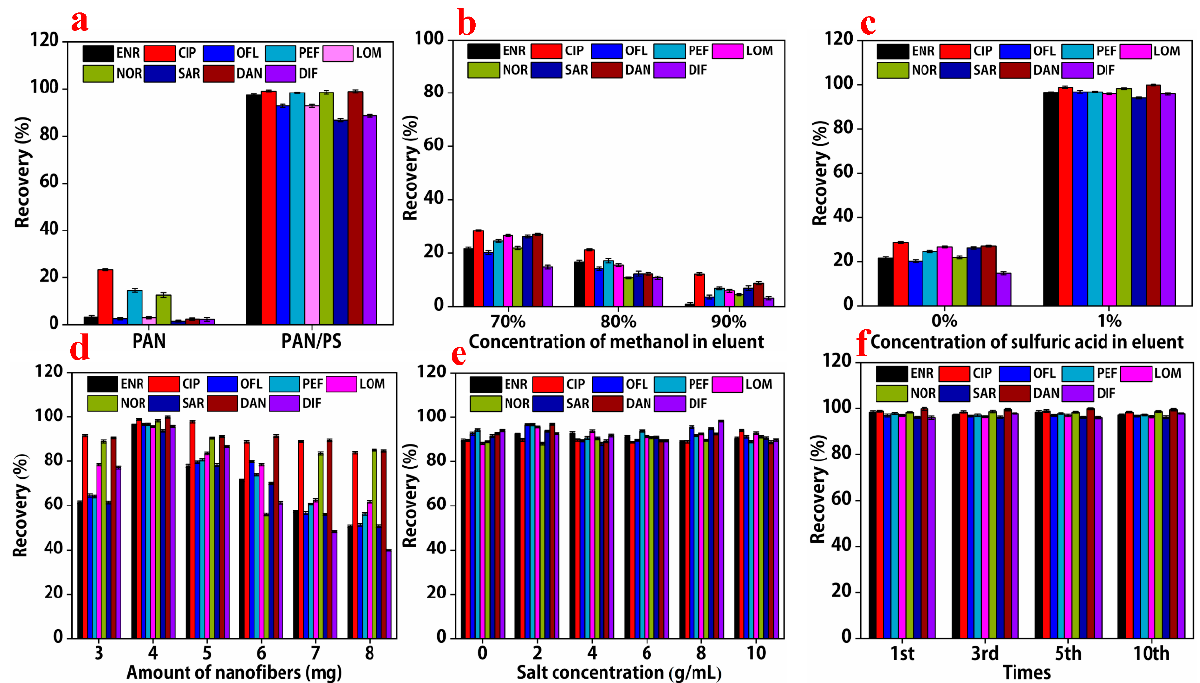
Figure 5. ( a ) Adsorption efficiency of nine quinolones onto PAN and PAN-PS nanofiber extraction columns; ( b – e ) effects of methanol concentration in the eluent, sulfuric acid concentration in the eluent, the amount of nanofibers, and salt concentration on the extraction efficiency at a concentration of 50 ng/mL for nine quinolones; ( f ) effect of the run number for reproducibility on extraction efficiency at the concentration of 50 ng/mL for nine quinolones.